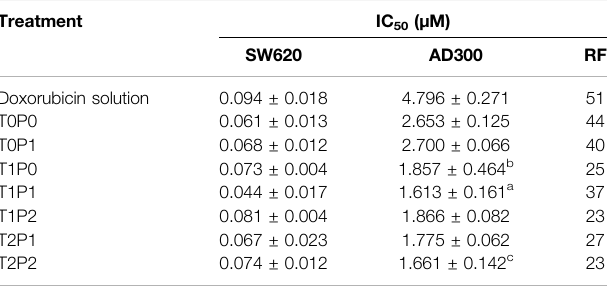
TABLE 2 | The IC 50 values calculated from cytotoxicity pro fi les doxorubicin- loaded PBCA-NPs formulations from MTT assays performed on SW620 and AD300 cell lines (data present mean ± SD, n (cid:1) 3).